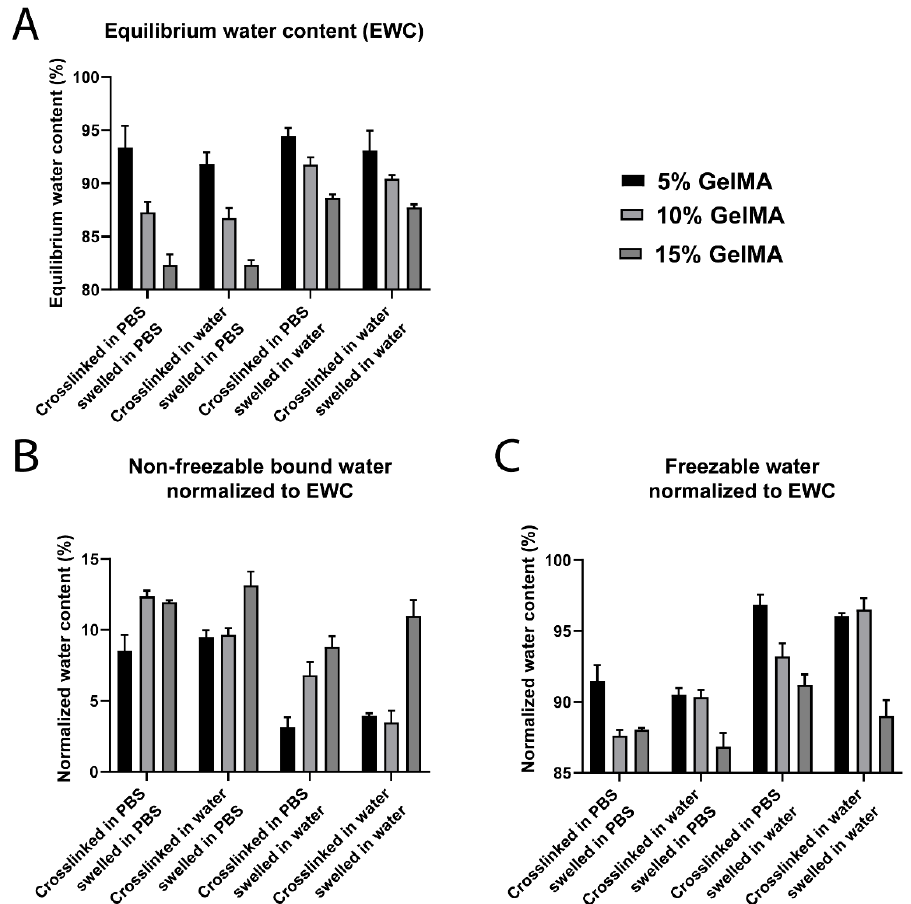
Figure 2. Water content and water types for GelMA hydrogels (5% to 15% gel fraction) crosslinked and swelled in different media. ( A ) Equilibrium water content ( EWC , n = 5). ( B ) Non-freezable bound water ( W nfb ) normalized to the EWC ( n = 3). ( C ) Freezable water ( W f ) normalized to the EWC ( n = 3).